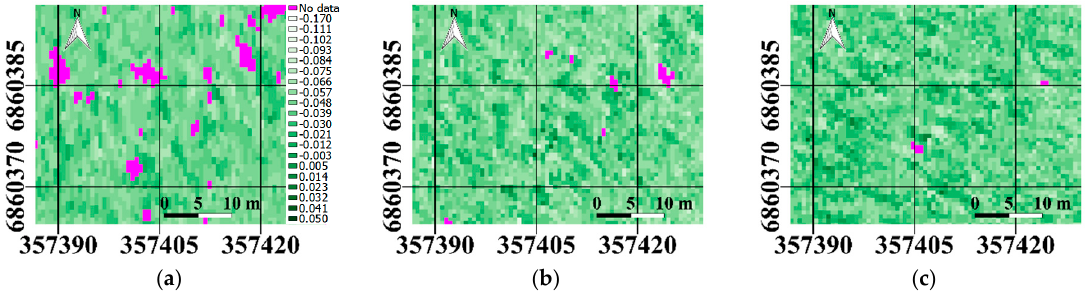
Figure 5. Spatial variation of the canopy PRI for β = 19 ◦ ( a ); β = 55 ◦ ( b ); and β = 76 ◦ ( c ). Purple pixels were masked out (NDVI < 0.8). The color scale is the same for all three rasters.